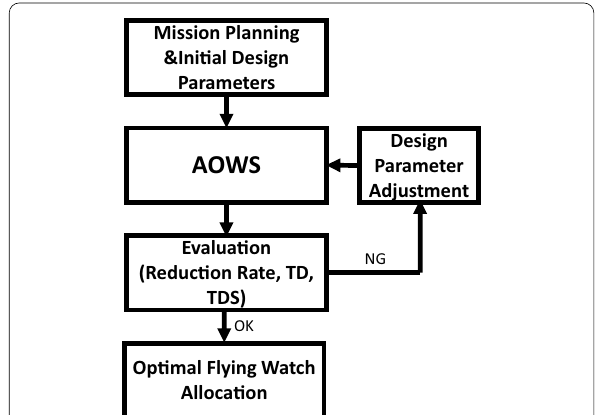
Fig. 3 The overall design process of flying watch allocation